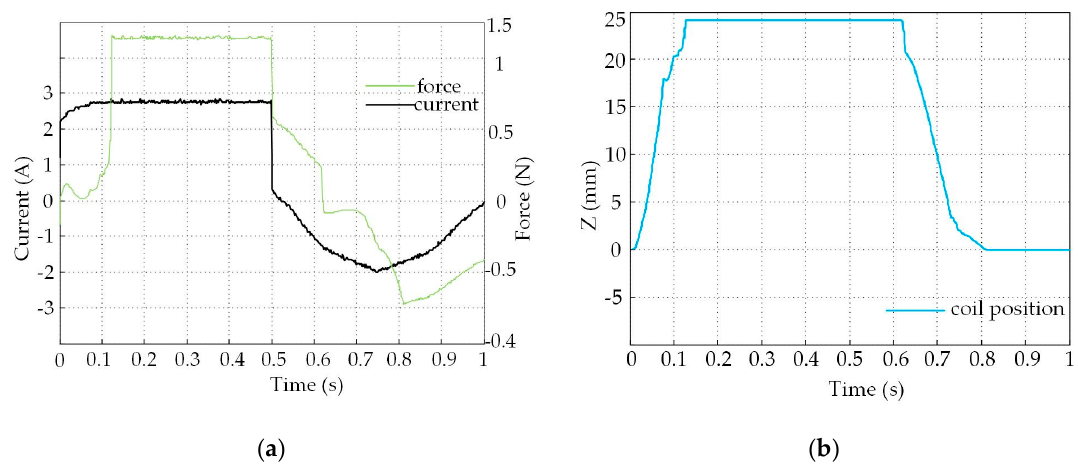
Figure 5. The force acting on the coil corresponding to the excited pulsed current in one period, ( a ) the force and current profiles; ( b ) the coil displacement.